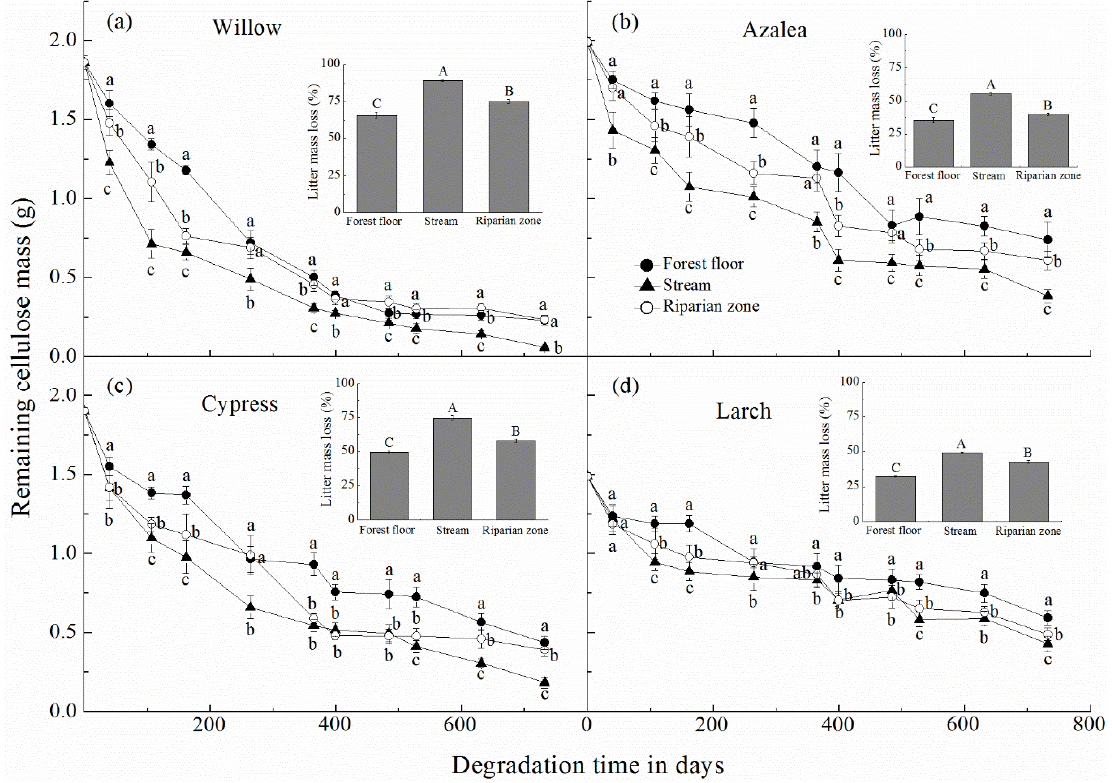
Figure 1. Dynamics of remaining cellulose mass (g) in decomposing foliar litters of ( a ) willow; ( b ) azalea; ( c ) cypress; and ( d ) larch in different ecosystem types during the two-year experiment (mean ± SD, n = 9). Inserted figures are the foliar litter mass loss at the end of the two-year experiment. Different lowercase letters indicate statistically significant ( p < 0.05) differences of cellulose mass among different ecosystem types at each sampling event for a specific litter species; different uppercase letters indicate significant ( p < 0.05) differences of litter mass loss for a specific litter species among different ecosystem types.